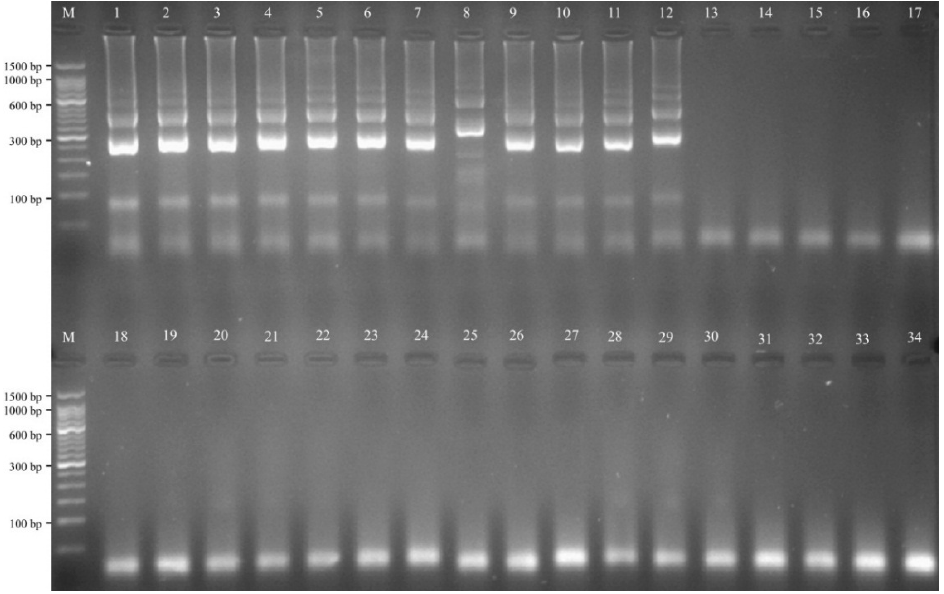
Figure 9. Specificity of MIP-LAMP detection for different strains. Lane M, DL 50-bp DNA